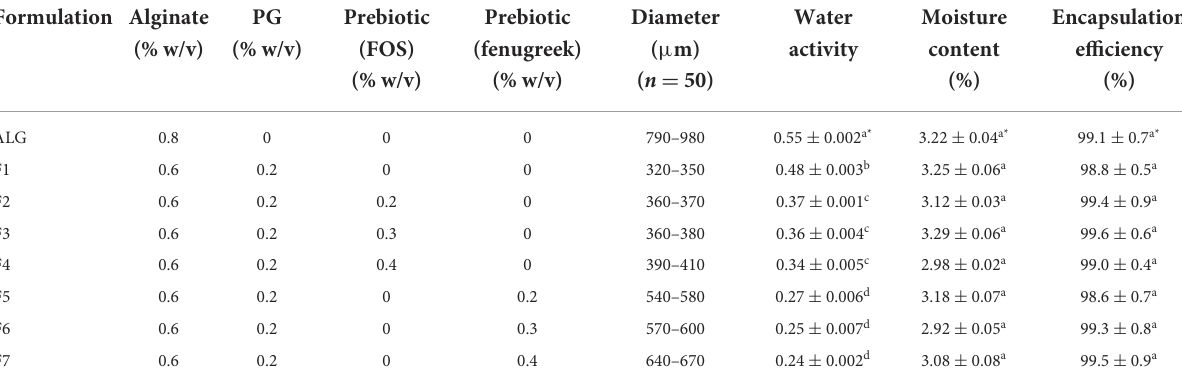
TABLE 2 Compositions, size, water activity, moisture content (%), and encapsulation efficiency (%) of microencapsulated Enterococcus faecium with various gel and prebiotic concentrations. Formulation